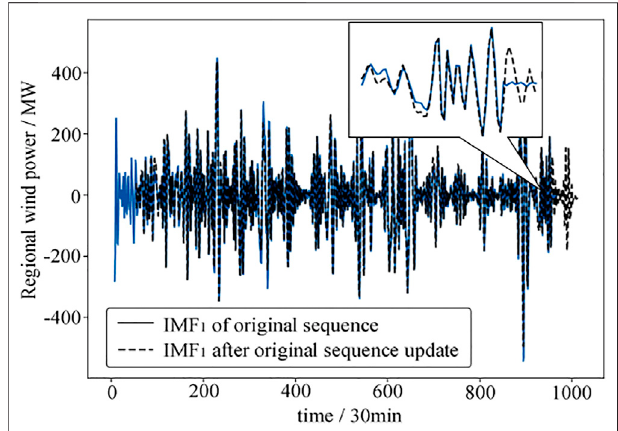
FIGURE 3 | Difference of IMF1 before and after updating training